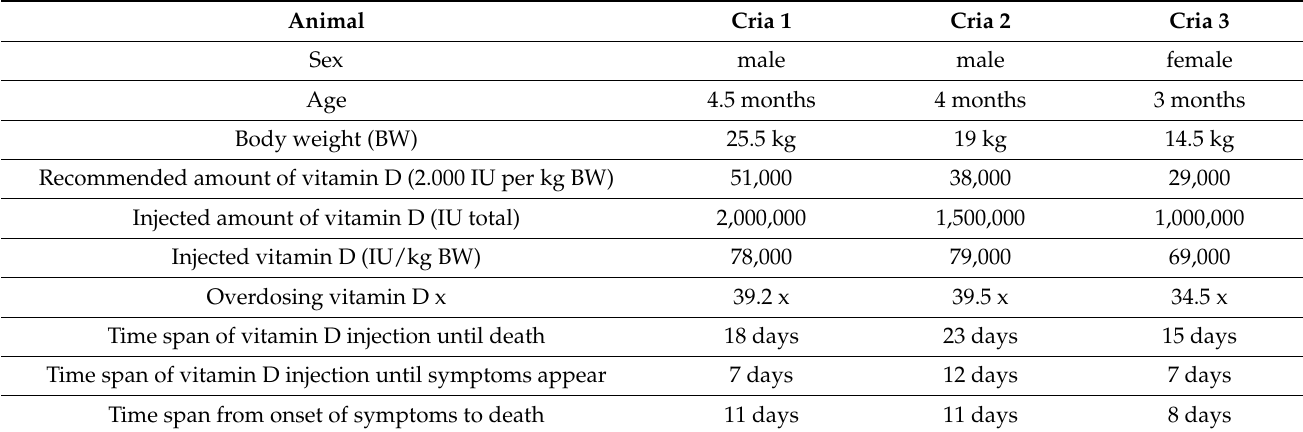
Table 1. Overview of the recommended and administered amounts of vitamin D for the three crias and the chronological sequence until the onset of symptoms and death. The recommended dose for vitamin D supplementation in alpacas is 2000 IU/kg body weight